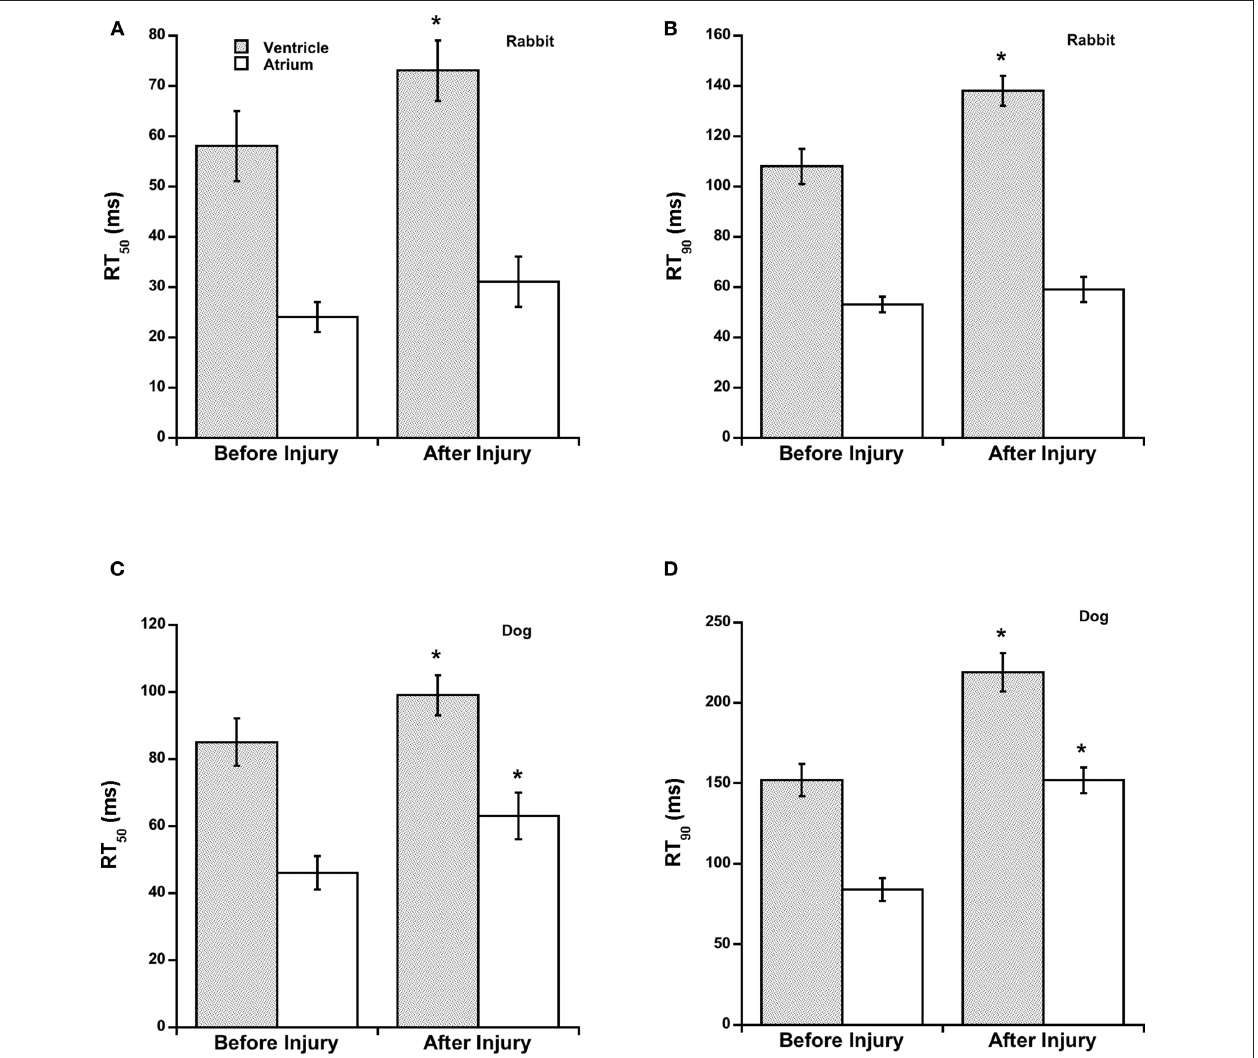
FiguRe 4 | Time from peak tension to 50% relaxation (RT50%) and time from peak tension to 90% relaxation (RT90%), before and after OH*-induced injury are significantly different in rabbit ventricular trabeculae, and in dog ventricular and atrial trabeculae. * indicates a difference of p < 0.05 between conditions in the same group. (A) Rabbit, RT50, (B) Rabbit RT90, (C) Dog, RT50, (D) Dog,